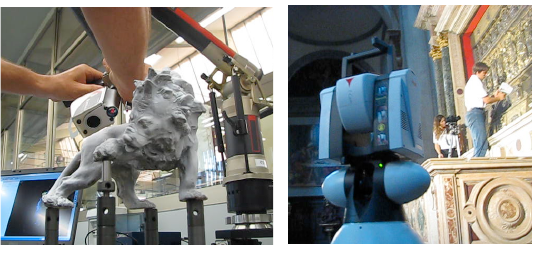
Figure 3. Triangulation laser scanner - laser